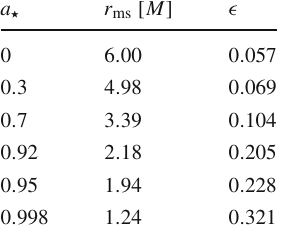
Table 3 Difference of the maxima of fluxes of radiation between RDSWH and Kerr BH, using a (cid:4) = 0 .